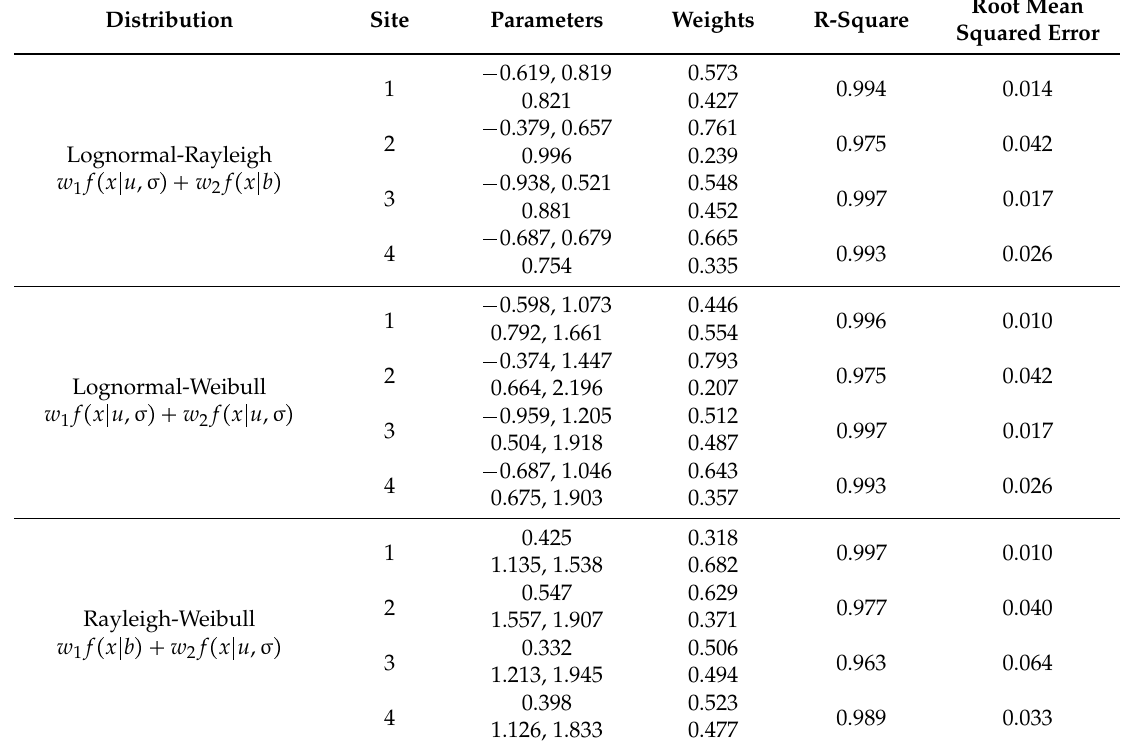
Table 5. R-square test and the corresponding parameters for the mixed-distributions to the four chosen